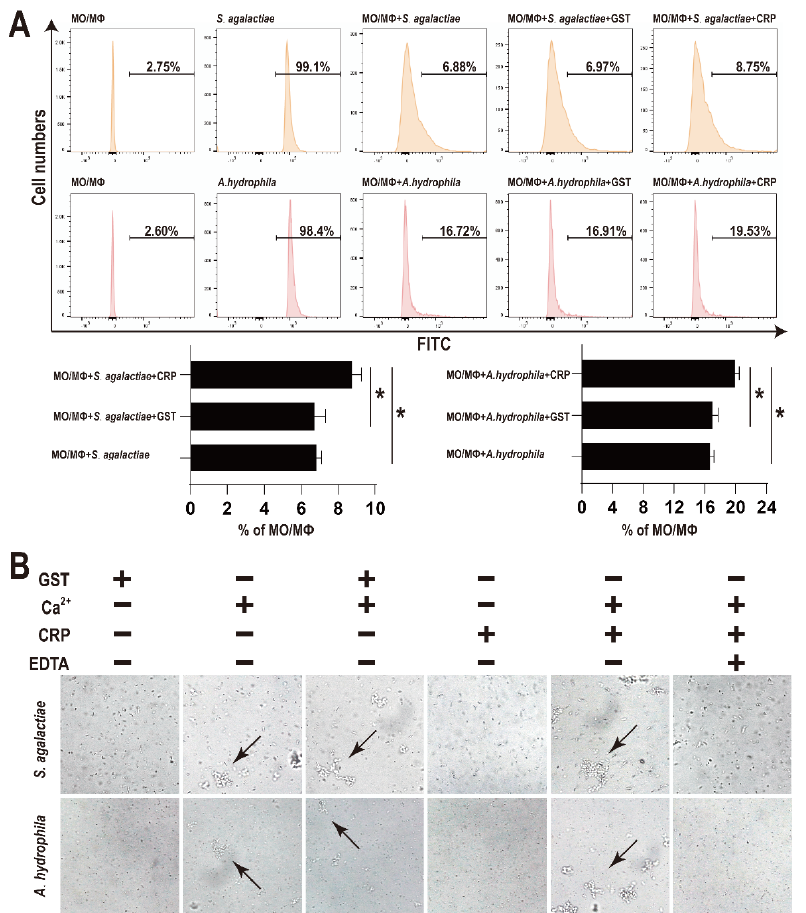
Figure 3. ( A ) Effects of rOn-CRP on phagocytosis activity of monocytes/macrophages. The FITC labelled bacteria were incubated with MO/M Φ and rGST-On-CRP (2 µM)/GST-tag protein (2 µM) for 0.5 h at room temperature. Significant differences are indicated by asterisks ( p < 0.05). ( B ) Bacterial agglutination caused by rOn-CRP. The bacteria were incubated with GST-tag protein (2 µM), CaCl 2 (10 mM), rGST-On-CRP (2 µM) and EDTA (20 µM) for 0.5 h at room temperature. Arrows point to the agglutinated bacteria. All photographs were observed at 400× magnification.